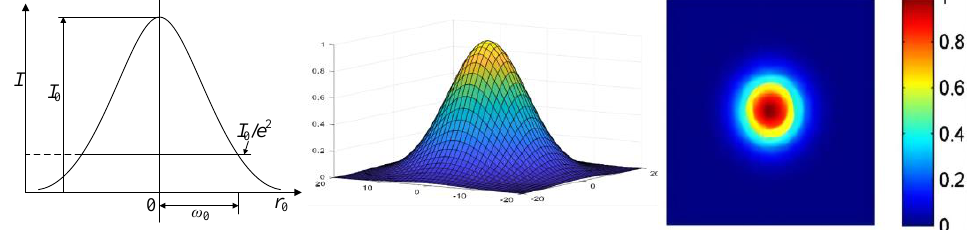
Figure 1. Intensity distribution of gaussian laser beams.